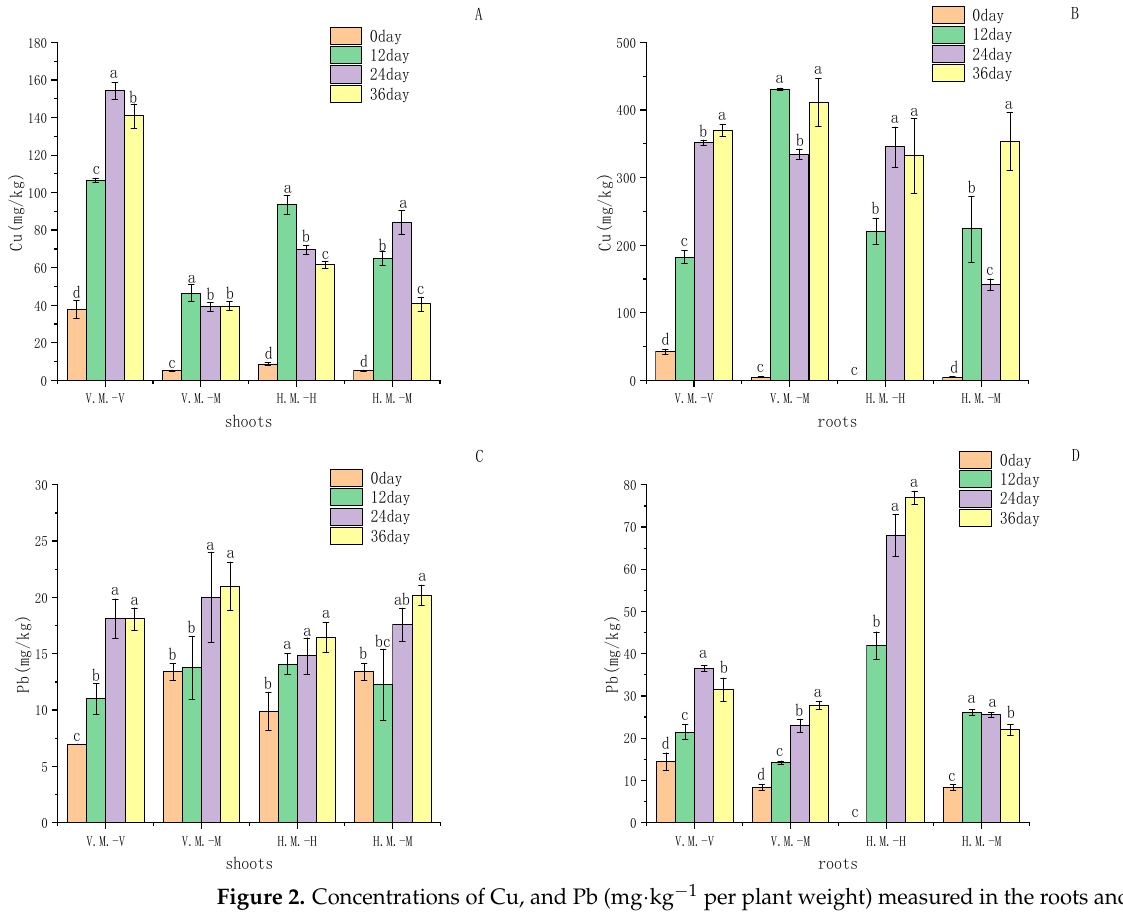
Figure 2. Concentrations of Cu, and Pb (mg · kg − 1 per plant weight) measured in the roots and shoots of plants Vallisneria natans (Lour.) Hara , Myriophyllum spicatum L. and Hydrilla verticillate (Linn. f.) Royle . The error bars represent standard deviation (n = 3). The letters a, b, c and d denote significant differences between treatments according to the LSD ( p < 0.05). ( A ): Cu content in plant shoots in mg/kg; ( B ): Cu content in plant roots in mg/kg; ( C ): Pb content in plant shoots in mg/kg; ( D ): Pb content in plant roots in mg/kg.